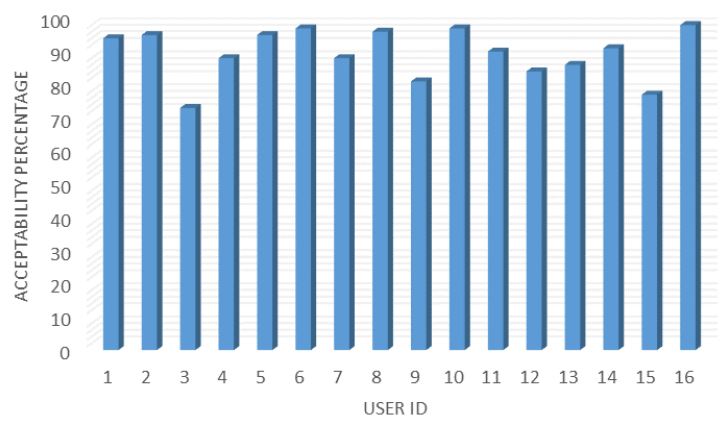
Figure 10. Robot acceptability percentage for the 16 users.